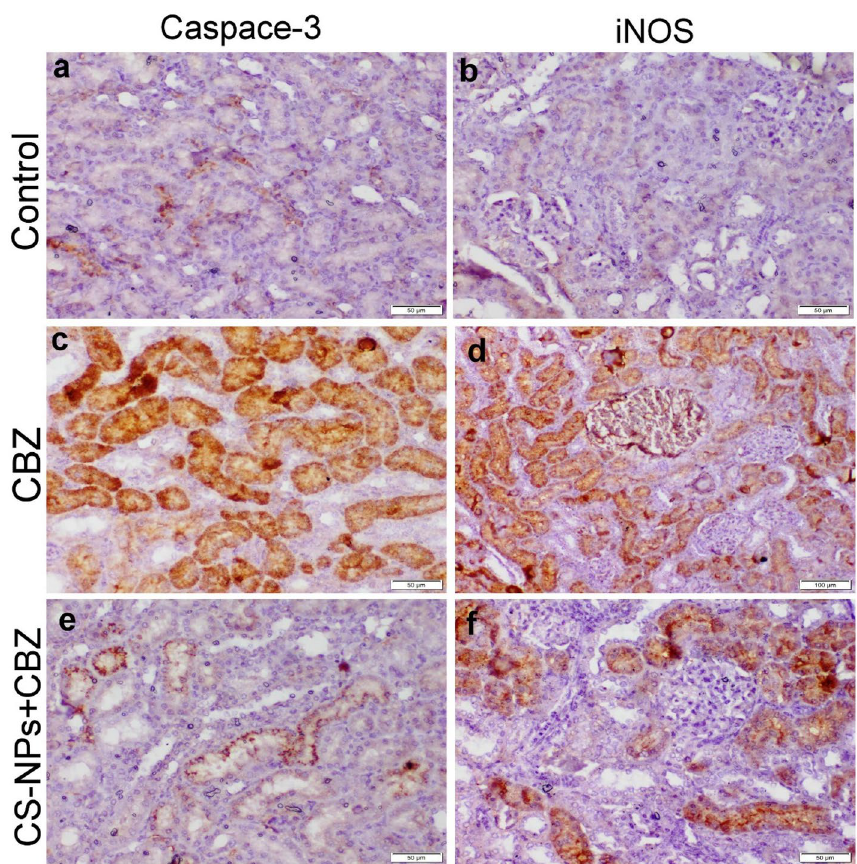
Figure 5. Photomicrograph of kidney tissue sections representing the localization of casp-3 and iNOS protein in different treated groups. ( a , b ) Control negative group showing normal slight to negative casp-3 and iNOS protein expression. ( c , d ) CBZ receiving group showing strong positive casp-3 and iNOS protein expression in the tubular epithelium and interstitial inflammatory cells. ( e , f ) CS-NPs + CBZ receiving group showing weak expressions of both casp-3 and iNOS